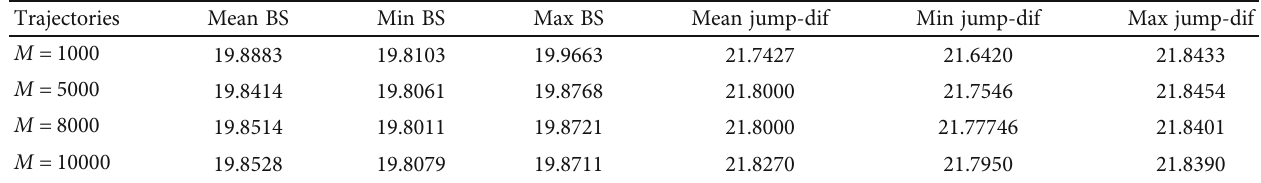
Figure 5: Asymptotic convergence of the least square algorithm M from 100 to 10000. Con fi dence level in order of 95% (the estimated value of the American option in blue, upper bound in red, and lower bound in green). Table 1: Con fi dence interval according to the number of sampling.